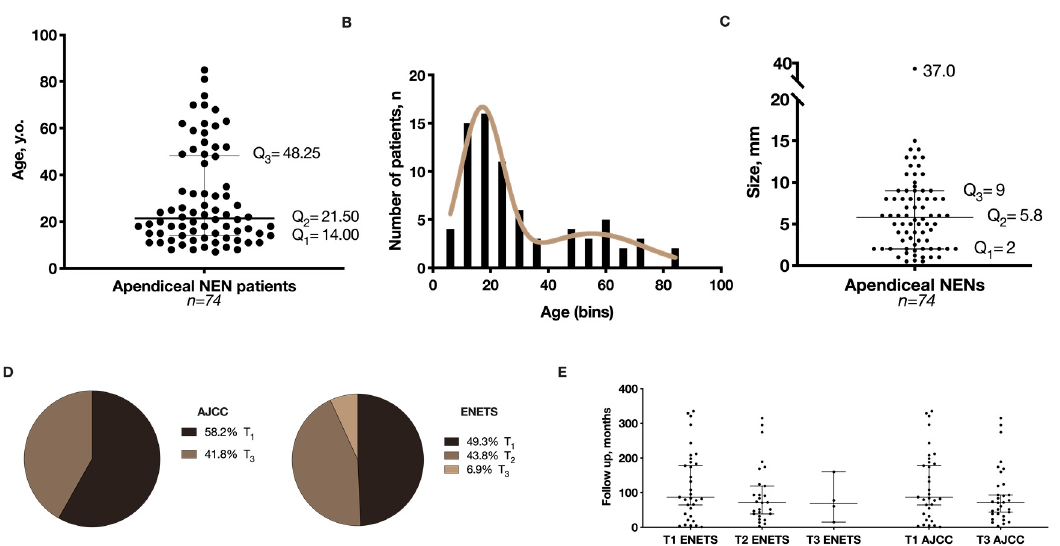
Figure 1. Graphical representation of ( A ) Age distribution of the appendiceal neuroendocrine neoplasms (NENs), median with interquartile range (IQR); ( B ) Bimodal distribution of age according to appendiceal NENs incidence; ( C ) Size distribution, median with IQR; ( D ) Patient staging (frequencies) according to European Neuroendocrine Tumour Society (ENETS) and the American Joint Committee on Cancer (AJCC) recommendations; and ( E ) Follow-up time distribution for ENETS and AJCC stage, median with